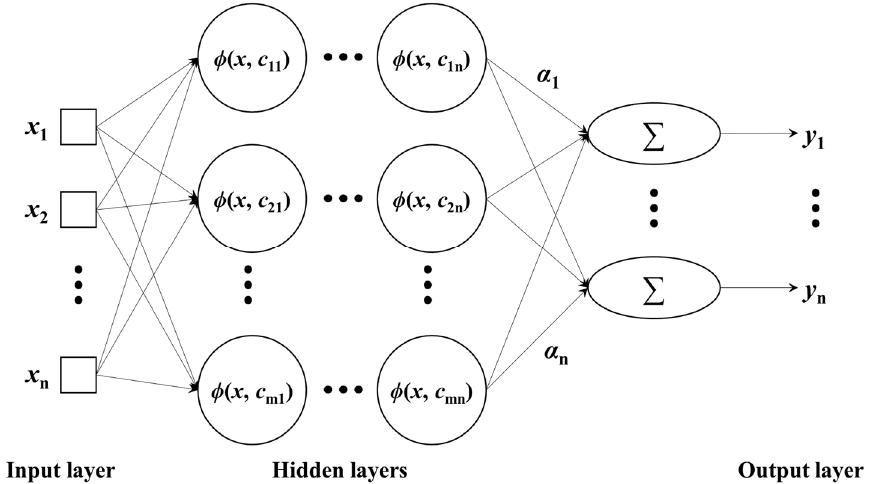
Figure 1. Neural network learning process of RBFNN.